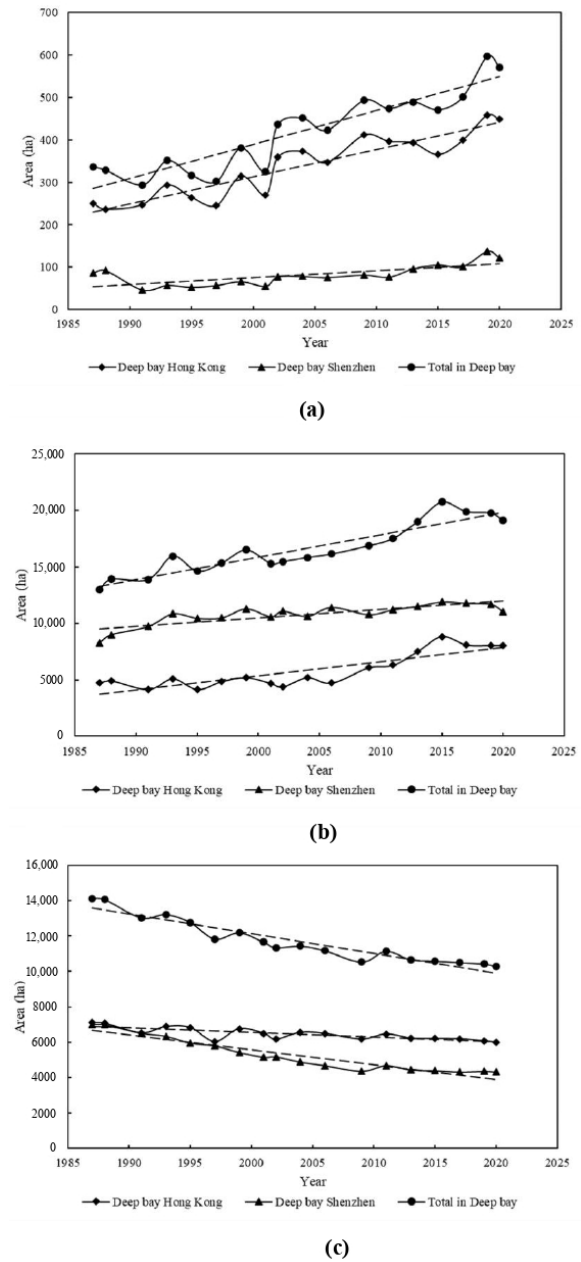
Figure 6. Areal changes of ( a ) mangrove habitats, ( b ) impervious surfaces, and ( c ) water and tidal mudflat in Deep Bay from 1987 to 2020.